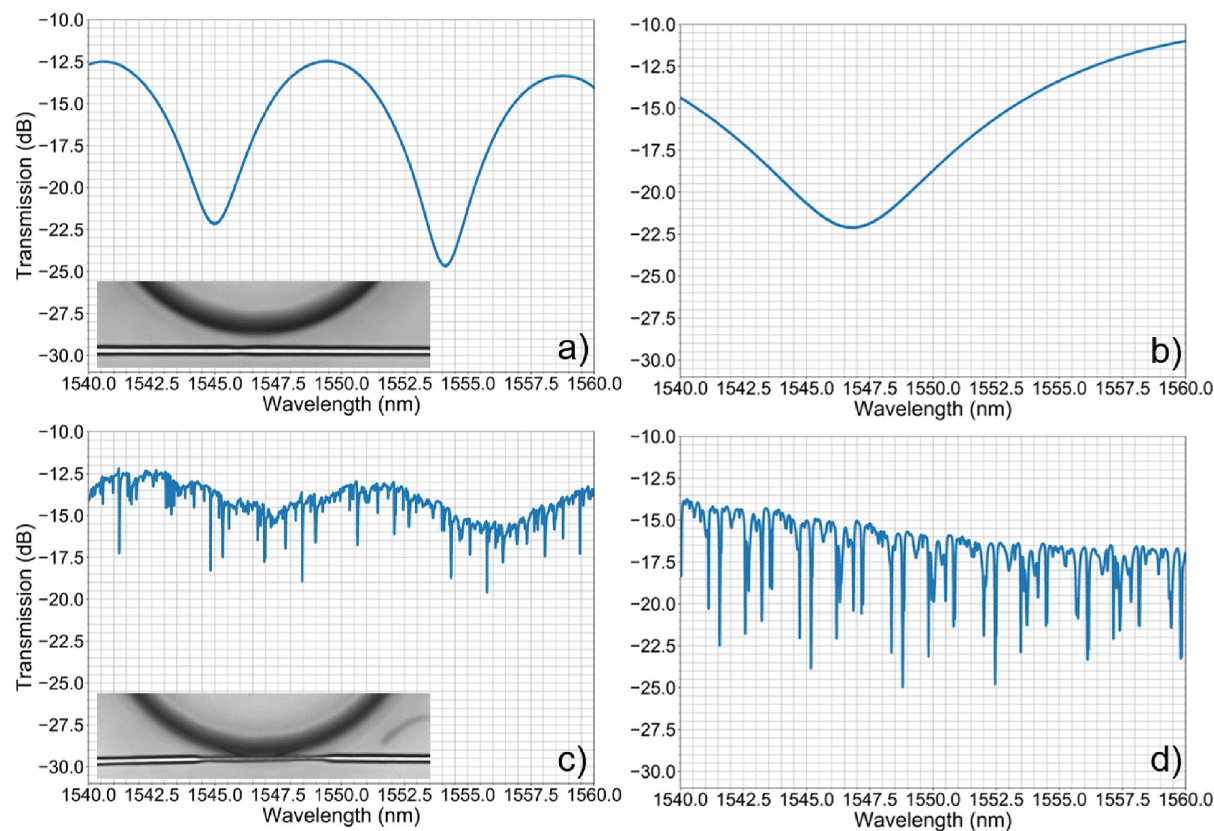
Figure 5. Transmission spectrum of the suspended waveguide. ( a , b ) Spectrum in air and deionized water, respectively, of a suspended waveguide with diameter of 3.7 µm, distanced of 2.2 µm from a 72 µm radius microdisk. ( c , d ) Spectrum in air and deionized water, respectively, of a suspended waveguide with waist diameter of 2.4 µm and tangent to a 72 µm radius microdisk. The inset images show a top view image of the respective device. The measurements were made from high magnification SEM